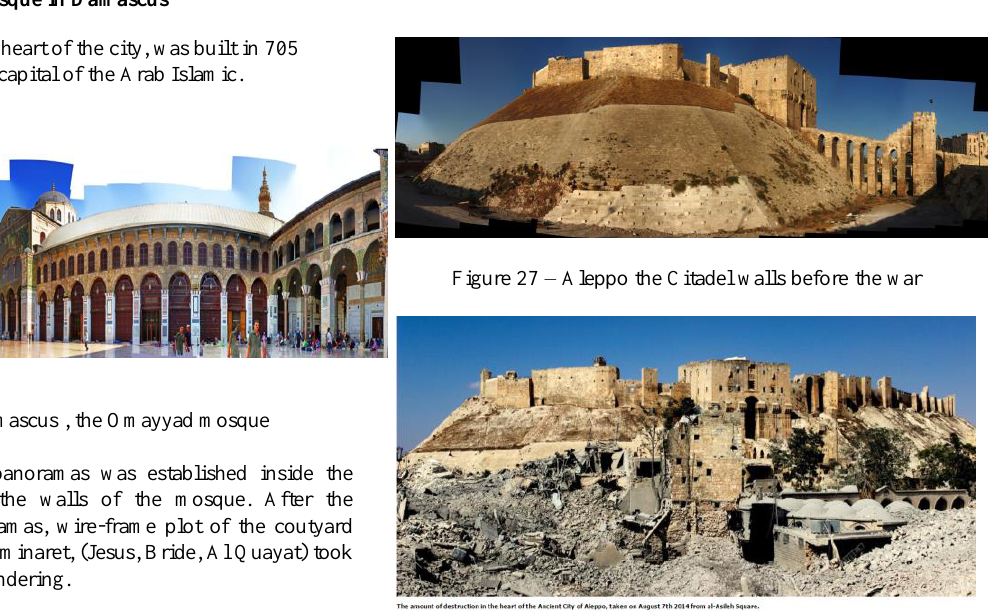
Figure 28 – Aleppo the Citadel walls during the war (photograph taken 14/8/14 ICC)